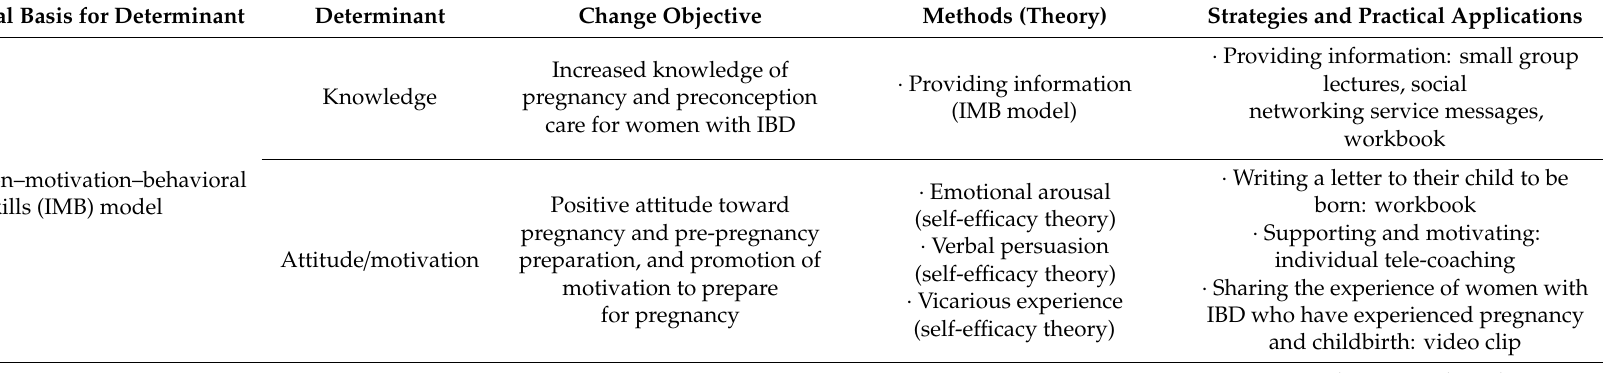
Table 3. Theoretical methods, strategies, and practical